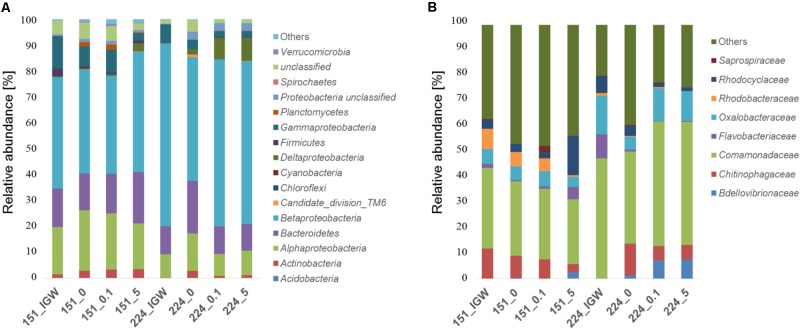
Relative abundance (%) of bacterial phyla/classes (A) and families (B) in groundwater from wells 151 and 224 (IGW: initial groundwater) and in laboratory experiments of groundwater without MET addition (0) or exposed to 0.1 mg L-1 and 5 mg L-1 MET during 21 days at 20°C.